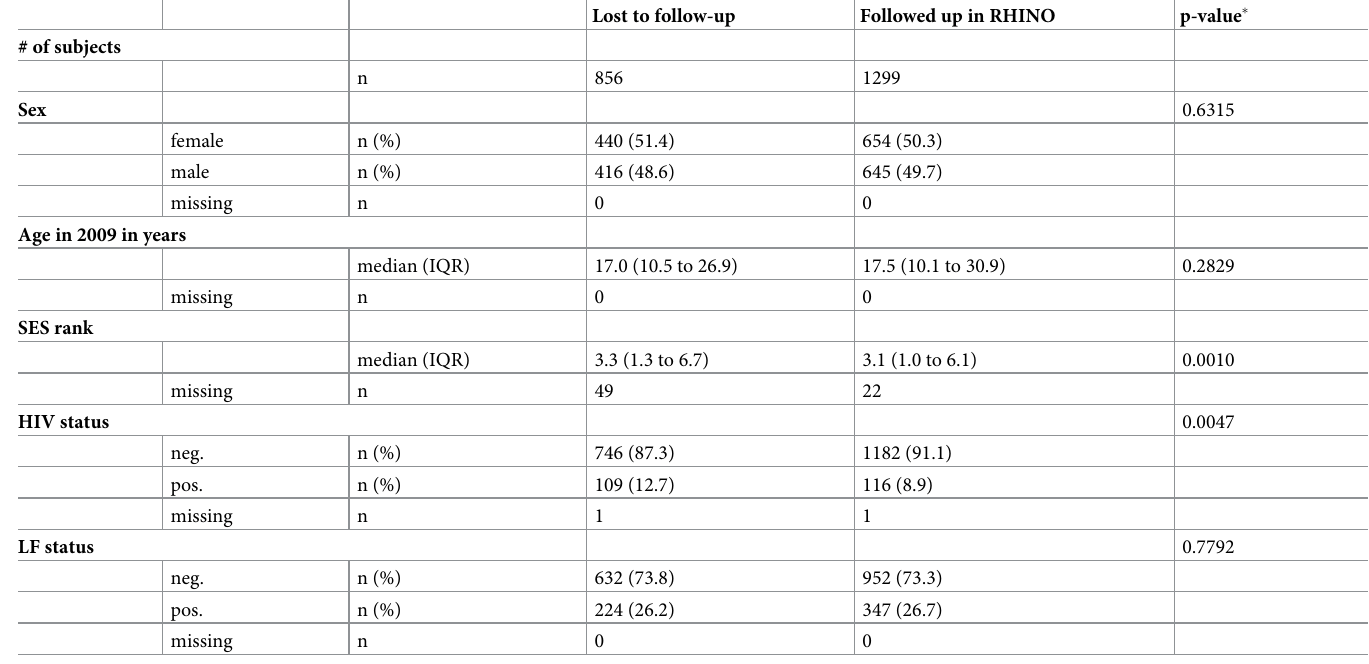
Table 1. Comparison of EMINI participants who were followed up in the RHINO study with those who were lost to